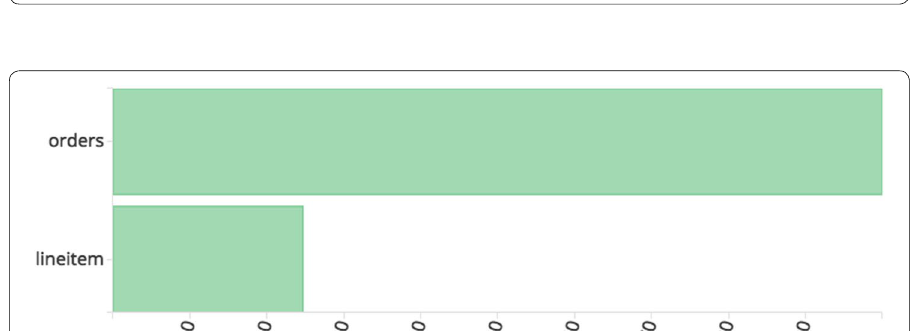
Fig. 11 Row validation chart for the difference count